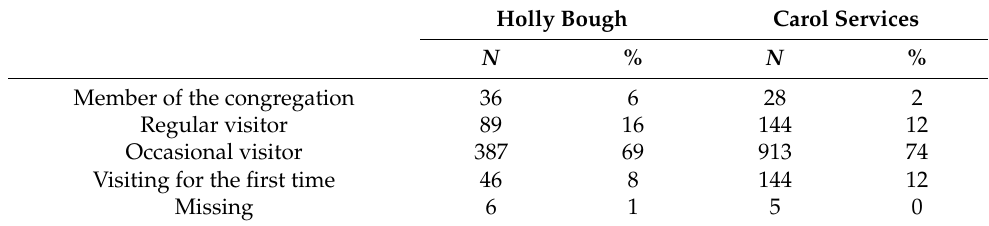
Table 6. Connection with Liverpool